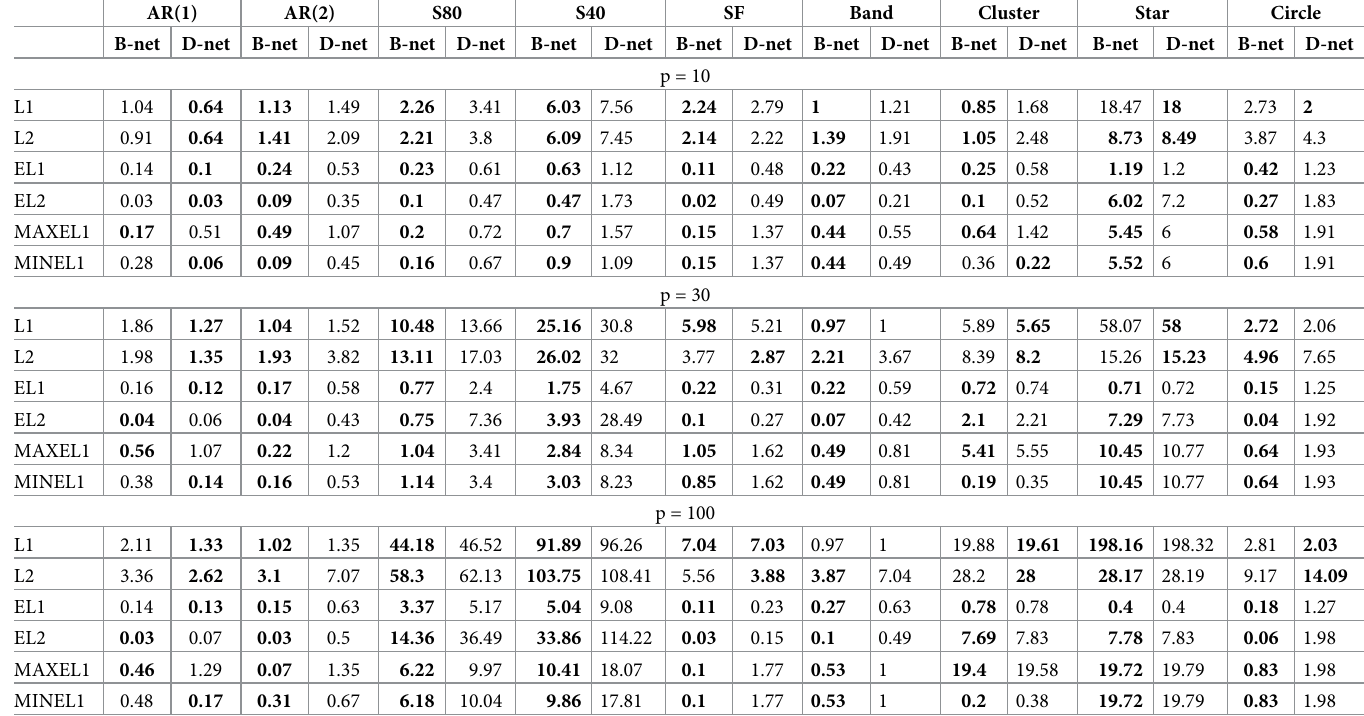
Table 2. Synthetic study median loss